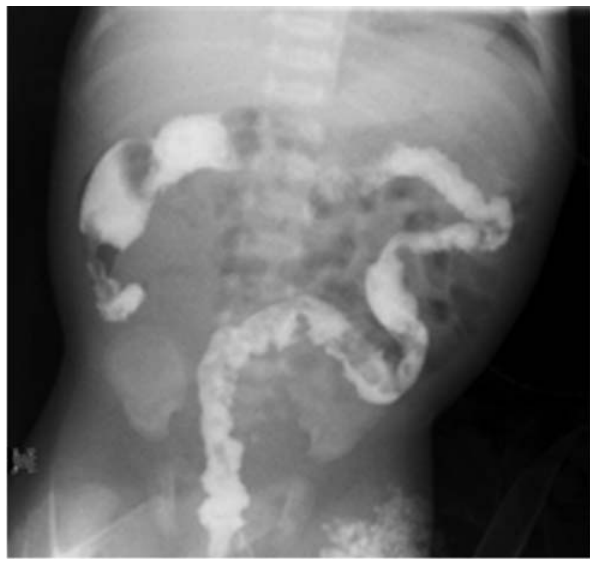
Fig. 1 Repeat contrast enema concerning for long-segment Hirsch- sprung disease: microcolon, the question mark-shaped colon, and the lack of features in an otherwise normal colon.